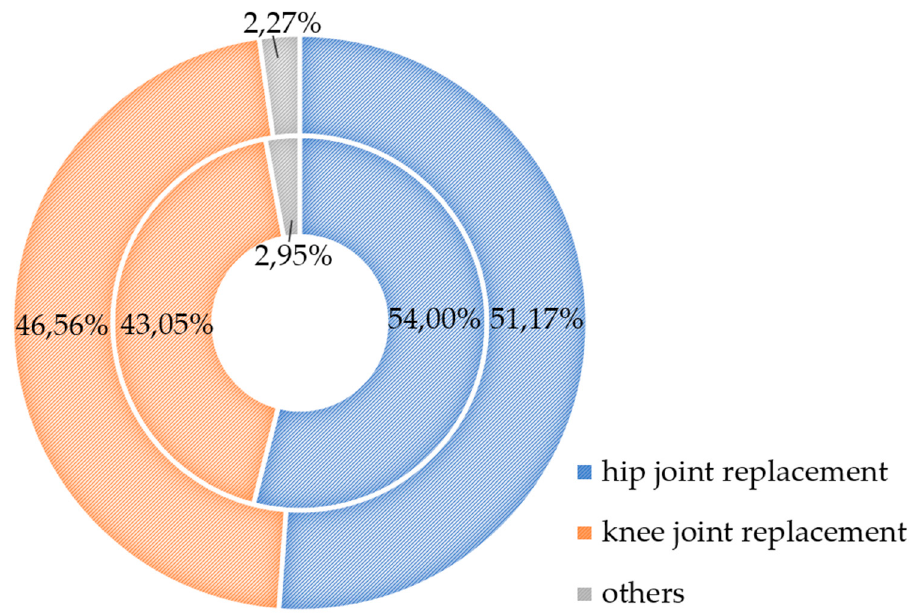
Figure 2. The structure of joint replacement operations in 2020 in the Russian Federation (outer ring—the number of joint replacement surgeries in adult patients; inner ring—the number of joint arthroplasty operations in persons older than working age).